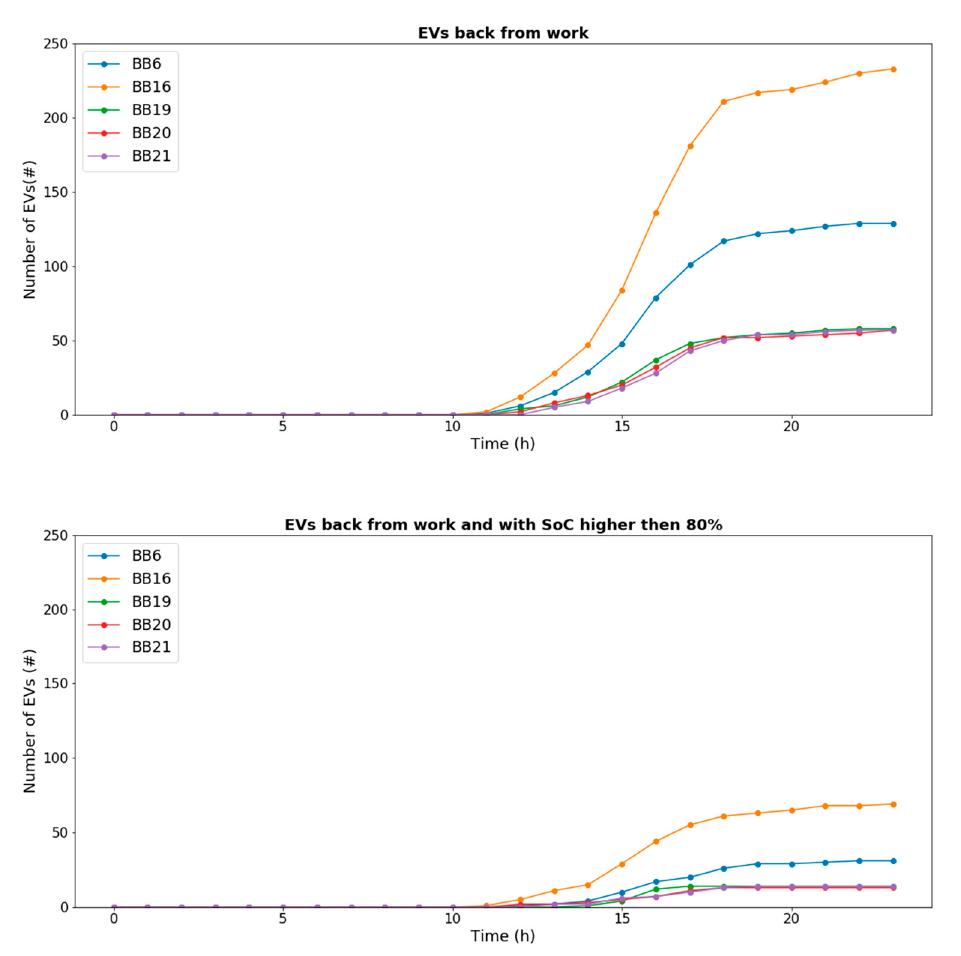
Figure 5. EVs’ availability at each BB station during the selected critical day.